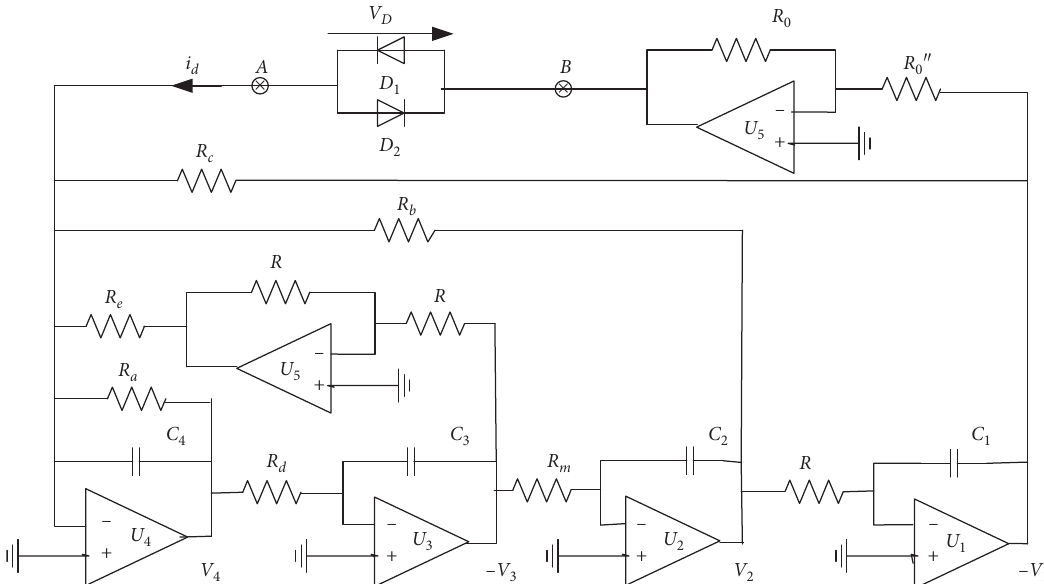
Figure 1: Electronic circuit realization of the novel 4-D hyperjerk system with hyperbolic sine nonlinearity. Its simplicity is remarkable. The pair of semiconductor diodes implements the hyperbolic nonlinearity of the model. Table 1: List of electronic components used during the